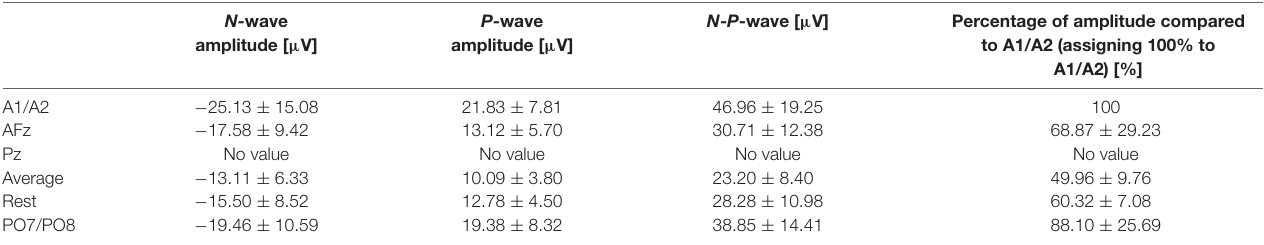
TABLE 1 | N -, P -, and N - P -wave amplitudes for every reference site for the 54 ◦ C stimulation temperature and their respective standard deviations. N- wave P -wave N - P -wave [ µ V] Percentage of amplitude compared amplitude [ µ V] amplitude [ µ V] to A1/A2 (assigning 100% to